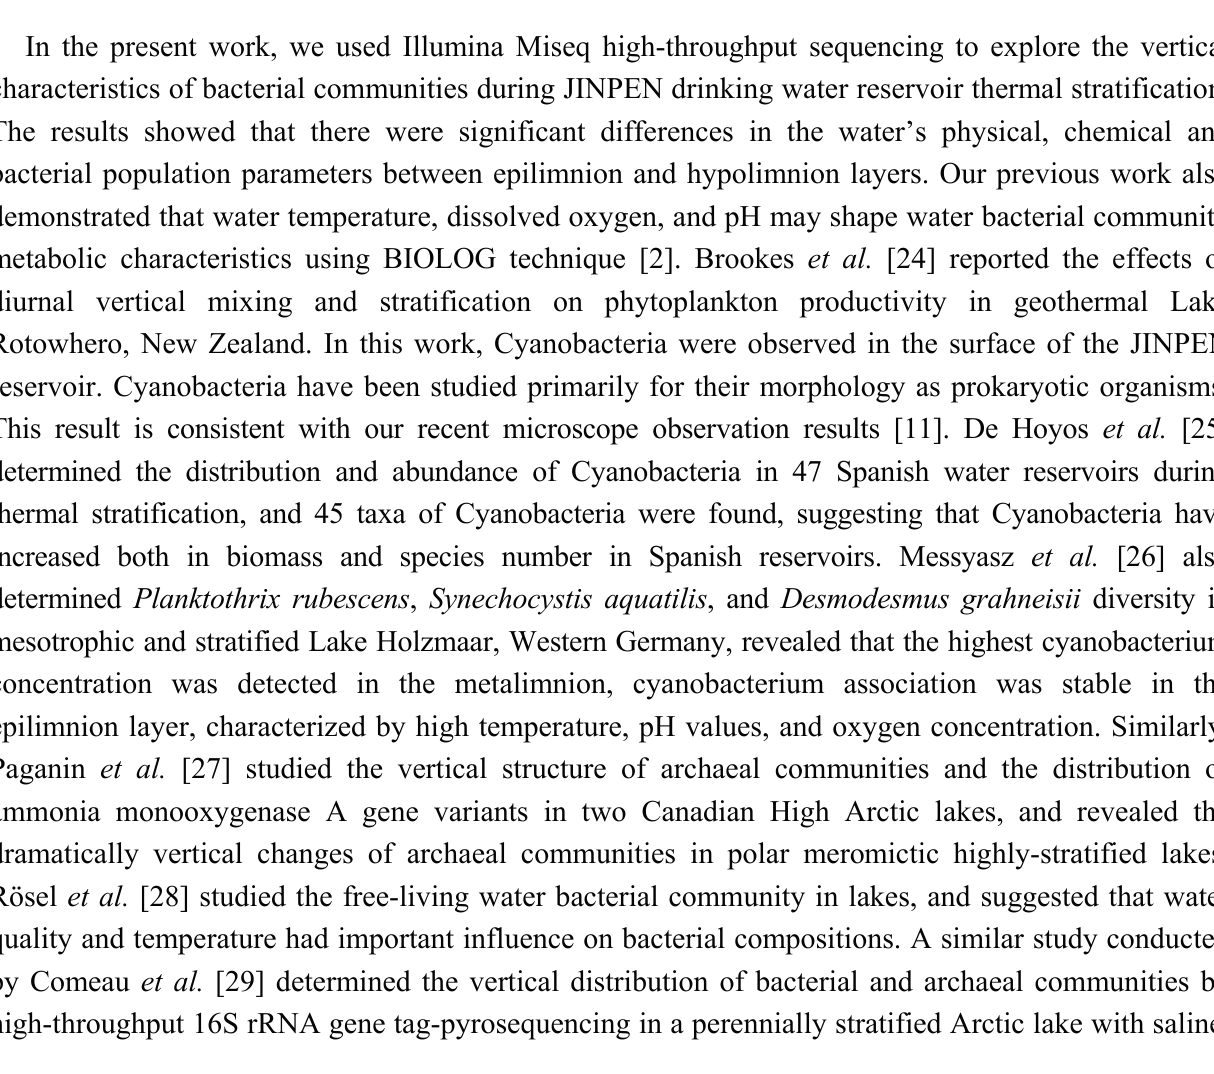
Figure 5. Redundancy analyses of vertical water bacterial communities in the JINPEN drinking water reservoir during thermal stratification. RDA1 explained 56.38%, and RDA2 explained 23.62% of the total